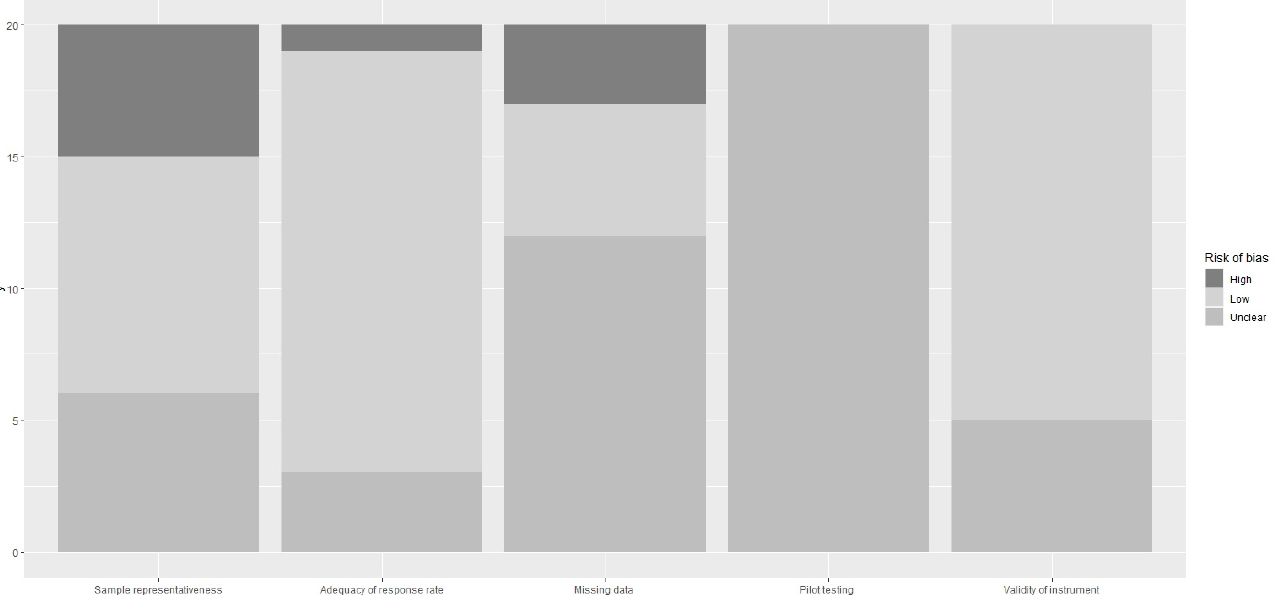
Figure 2. Risk of bias assessment .